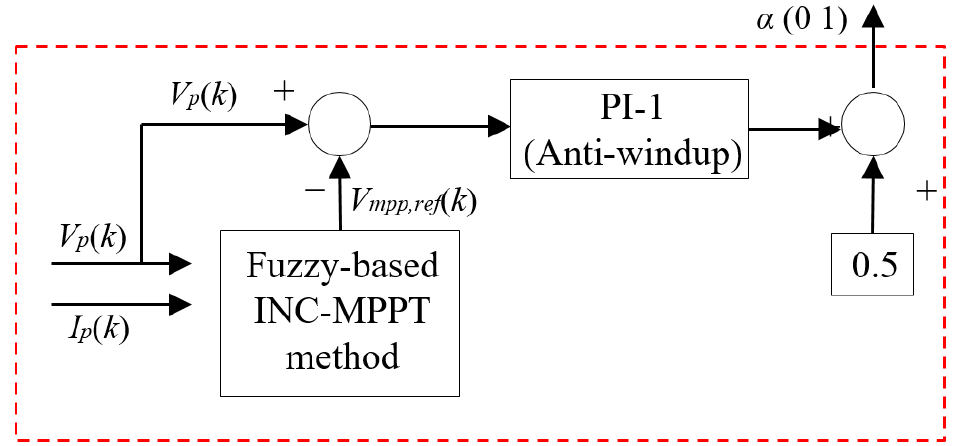
Figure 4. MPPT controller module schematics.